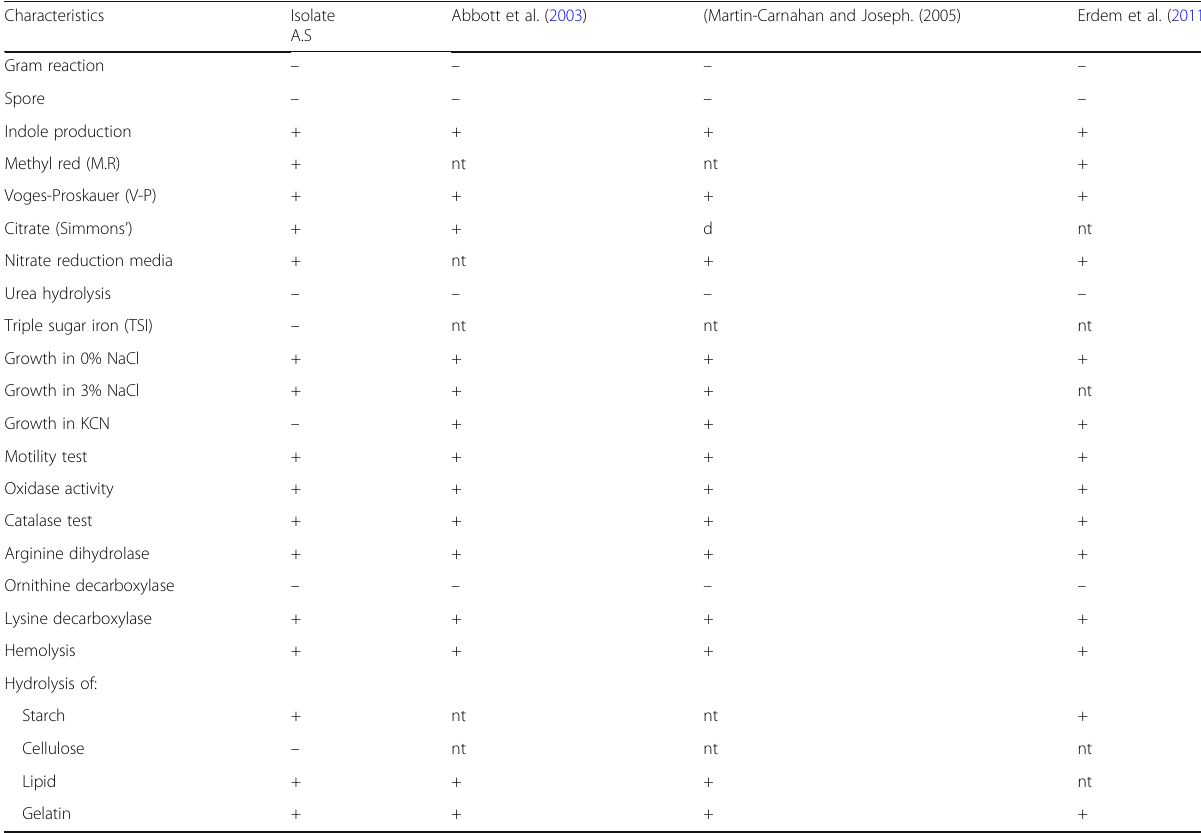
Table 2 Physiological and biochemical characteristics of isolate A.S compared to those reported for Aeromonas hydrophila by Abbott et al. (2003), Martin-Carnahan and Joseph (2005), and Erdem et al. (2011)